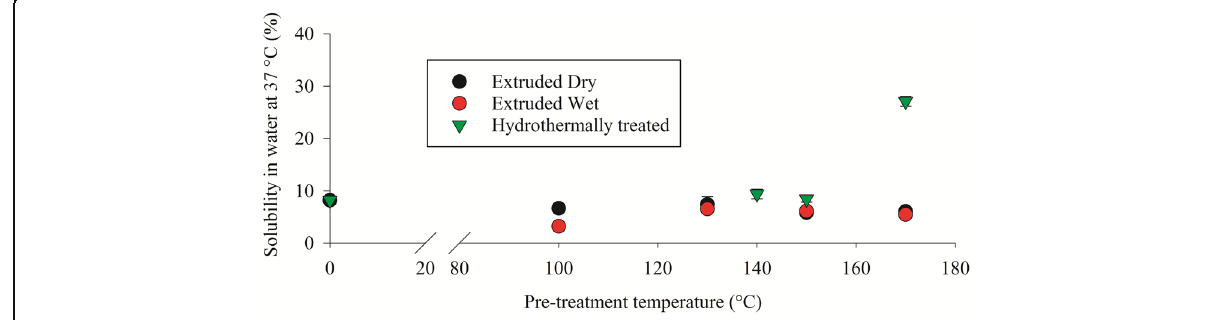
Fig. 4 Solubility in water of extruded shavings, shavings treated hydrothermally, and